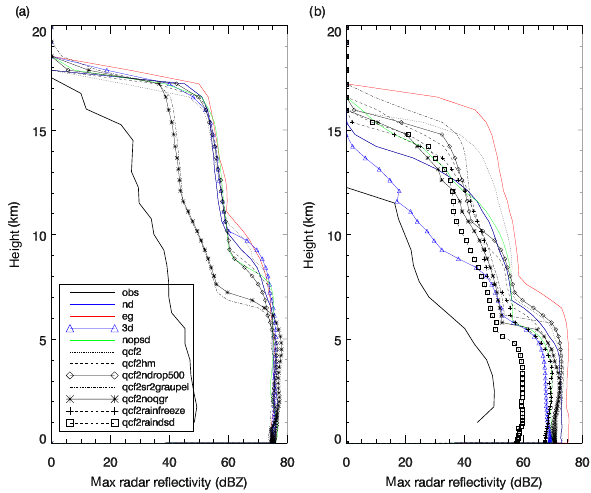
Figure 10. Profiles of maximum radar reflectivity for the times (a) 17:00–18:00UTC and (b)